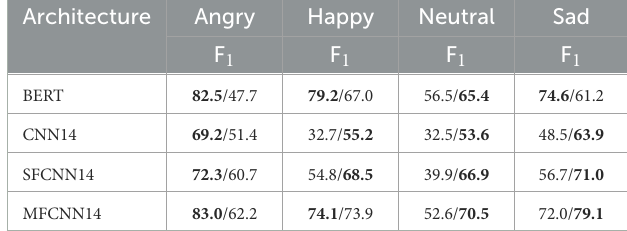
TABLE 6 F 1 scores for different categorical emotions for the scripted (S) vs. improvised (I) utterances of IEMOCAP (reported as S/I).